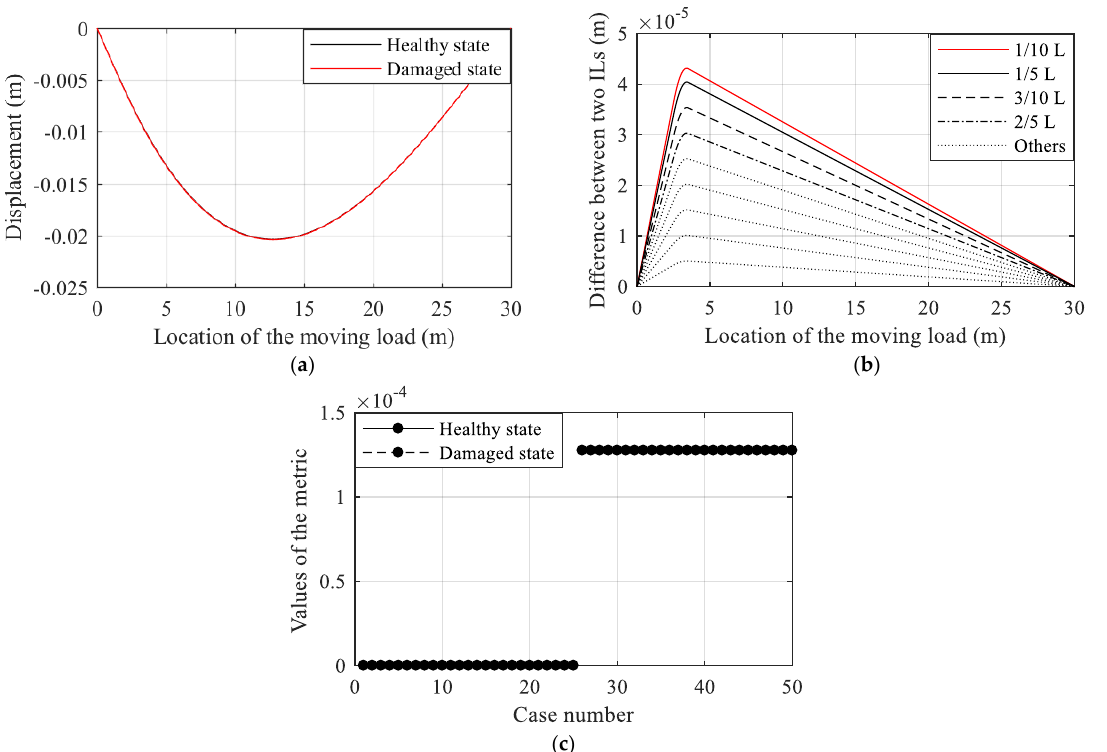
Figure 5. Displacement influence lines (ILs) obtained by 9 sensors for a ``y bridge.